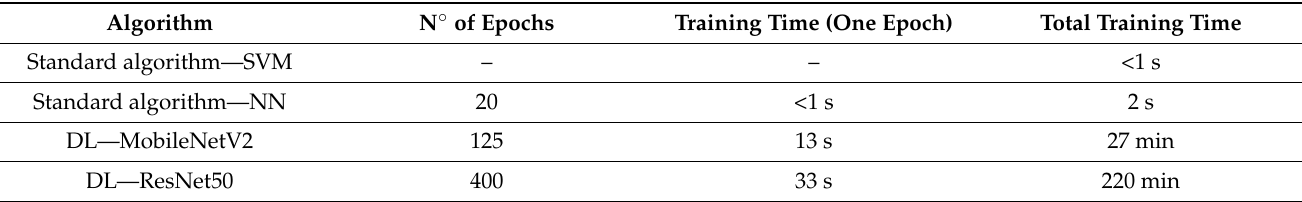
Table 6. Training time of the different